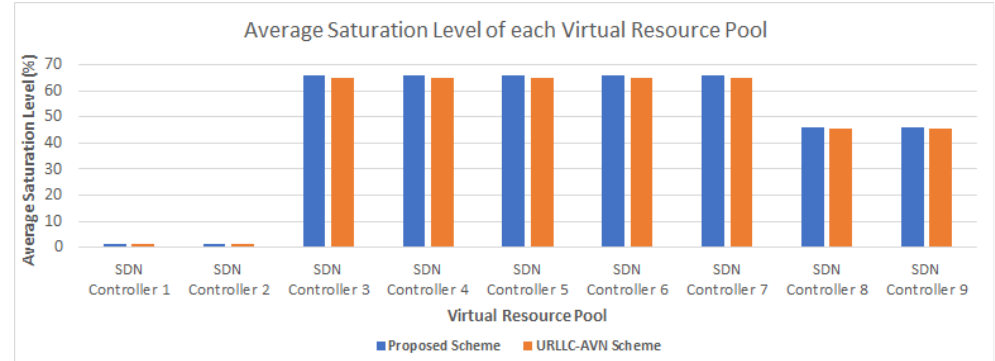
Figure 10. The average resource saturation level observed in each Virtual Resource